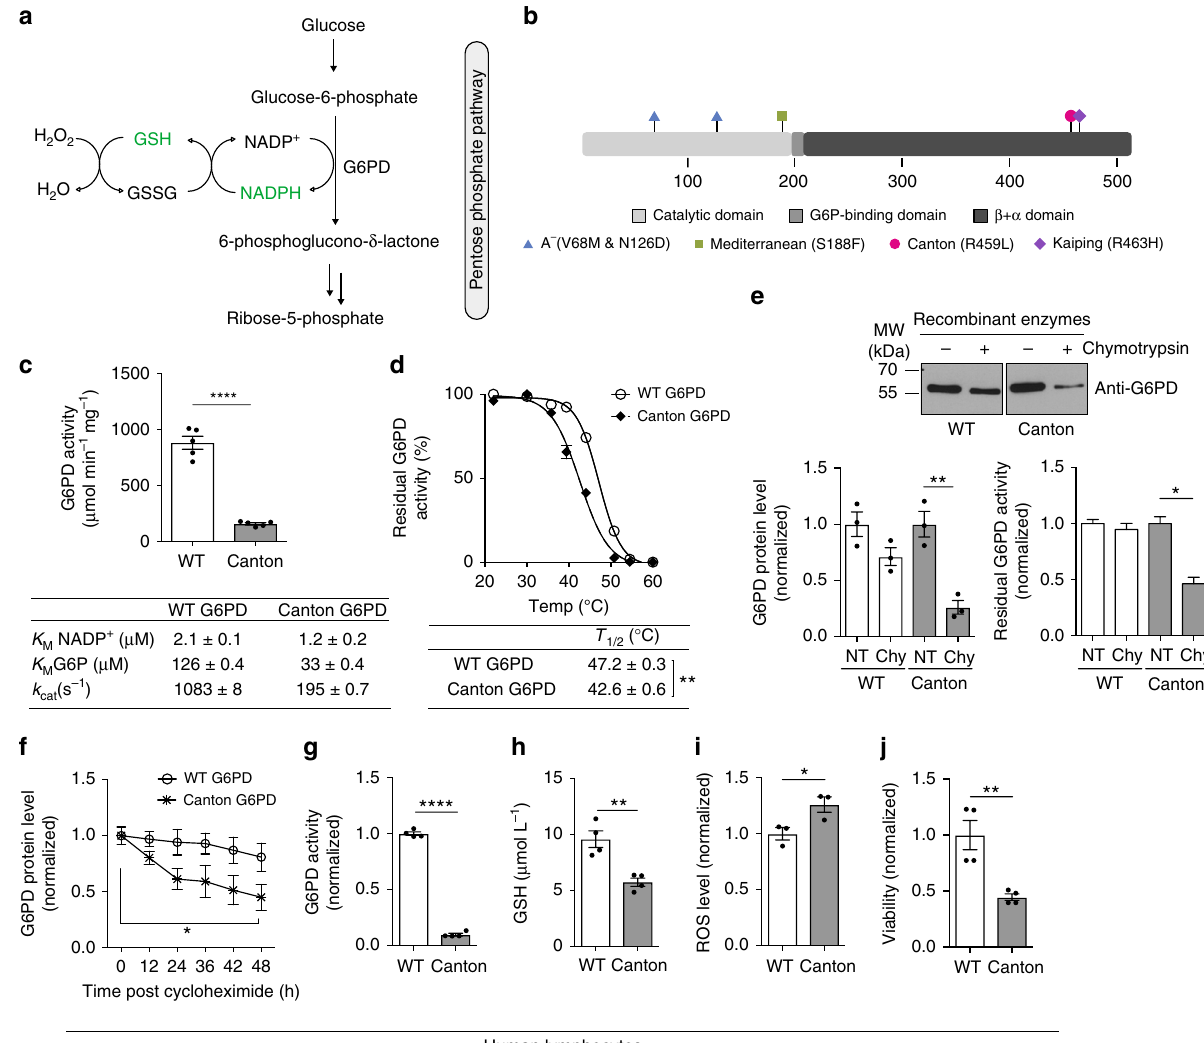
Fig. 1 Canton G6PD (R459L) variant is biochemically different from WT G6PD. a Enzymatic scheme of G6PD activity. b A linear map of G6PD domain structure with most common variants indicated. c Catalytic activity of recombinant WT G6PD and Canton G6PD enzymes with kinetic parameters ( n = 5, **** p < 0.0001). d Thermostability of WT G6PD and Canton G6PD enzyme ( n = 3, ** p = 0.003). e G6PD protein levels and residual G6PD activity (normalized to NT (no treatment) of each enzyme) after incubation with chymotrypsin for 1 h ( n = 3 for protein level assay, ** p = 0.0046; n = 2 for enzyme assay, * p = 0.024). f Protein stability assessment with cycloheximide treatment (50 μ g mL − 1 ), blocking de novo protein biosynthesis, in lymphocytes derived from corresponding subjects ( n = 3, * p = 0.013). Protein levels were normalized to the level of each enzyme at 0 h (no treatment). g G6PD activity was lower in cell lysates with Canton variant ( n = 4, **** p < 0.0001). h , i , j Lymphocytes with Canton variant generated less GSH and more reactive oxygen species (ROS) and were less viable ( n = 4, ( n = 3 for Fig. 1i), * p < 0.05, ** p < 0.01). Error bars represent mean ± SEM. Statistical differences were calculated by two-tailed unpaired Student ’ s t -test. NT: no treatment, WT: wild-type, Chy: